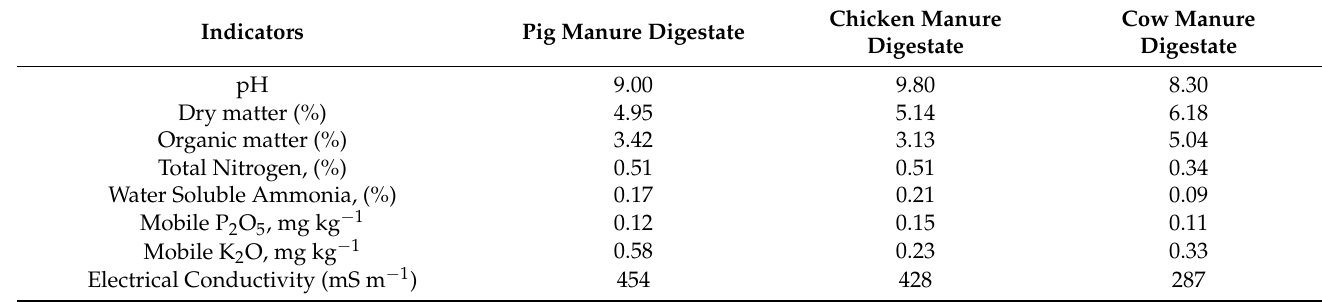
Table 3. Digestate physicochemical